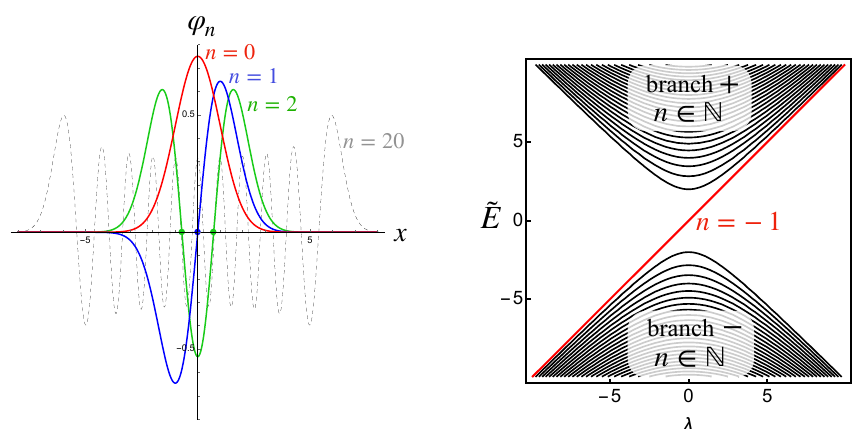
Figure 1: (Left) Spatial dependence of a few Hermite functions. (Right) Spectrum of ˜ H and of ˜ H . The spectral flow (red) between the two branches correspond to D W the eigenstate